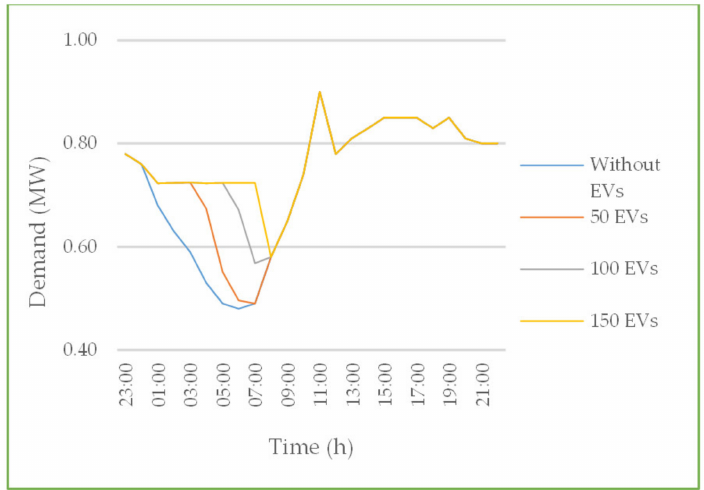
Figure 6. The effect of charging on LC2 when N = 50, 100 and 150 cars are used for valley filling between 23:00 and